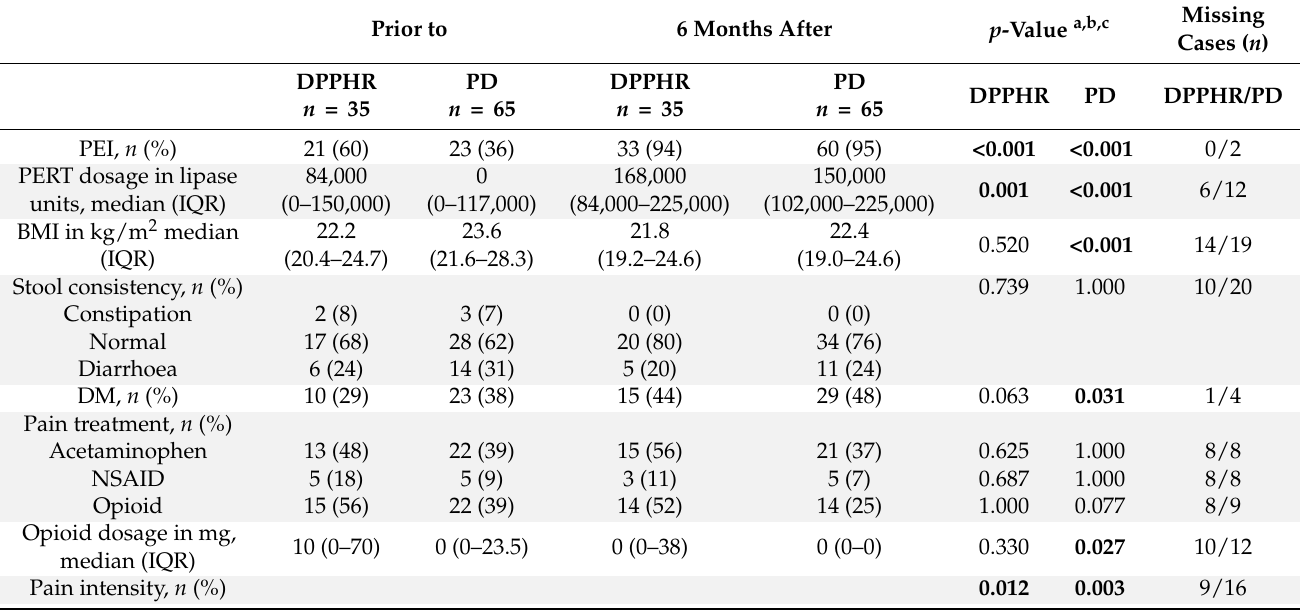
Table 4. Non-surgical data before and after duodenum-preserving pancreatic head resection (DPPHR) and pancreaticoduodenectomy